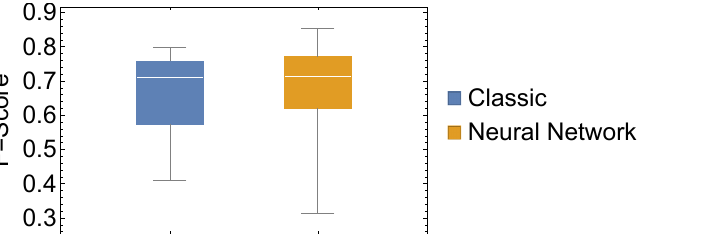
Figure 7. Experiment I: Box whisker chart of F-Score values of our 15 datasets for both consid- ered methods.